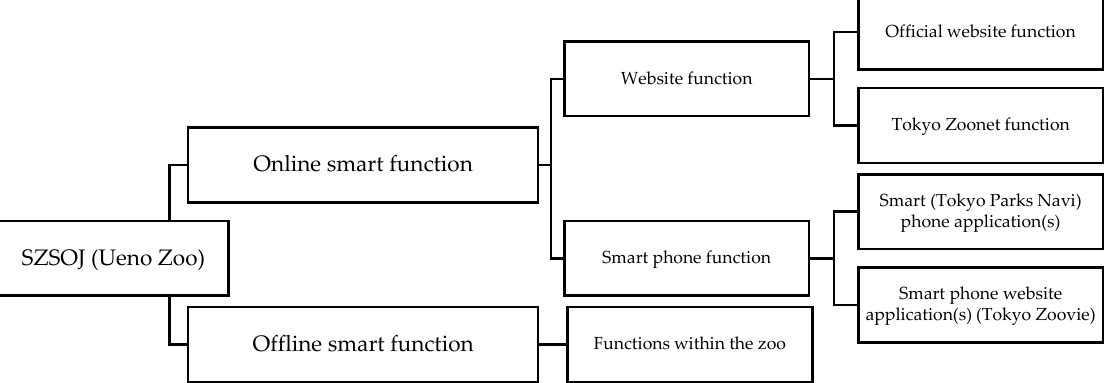
Figure 6. The suggested framework system of the future state of Ueno Zoo.